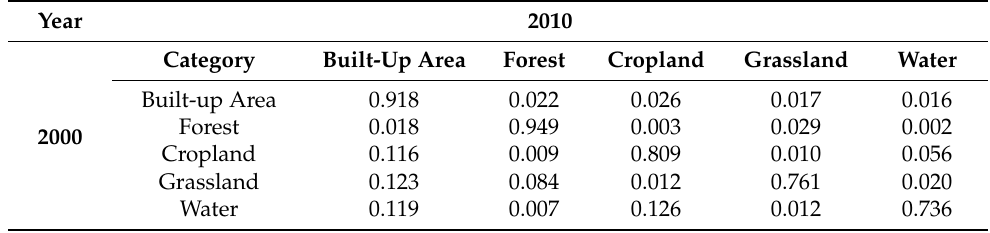
Table 8. Transition Matrix from 2000–2010.